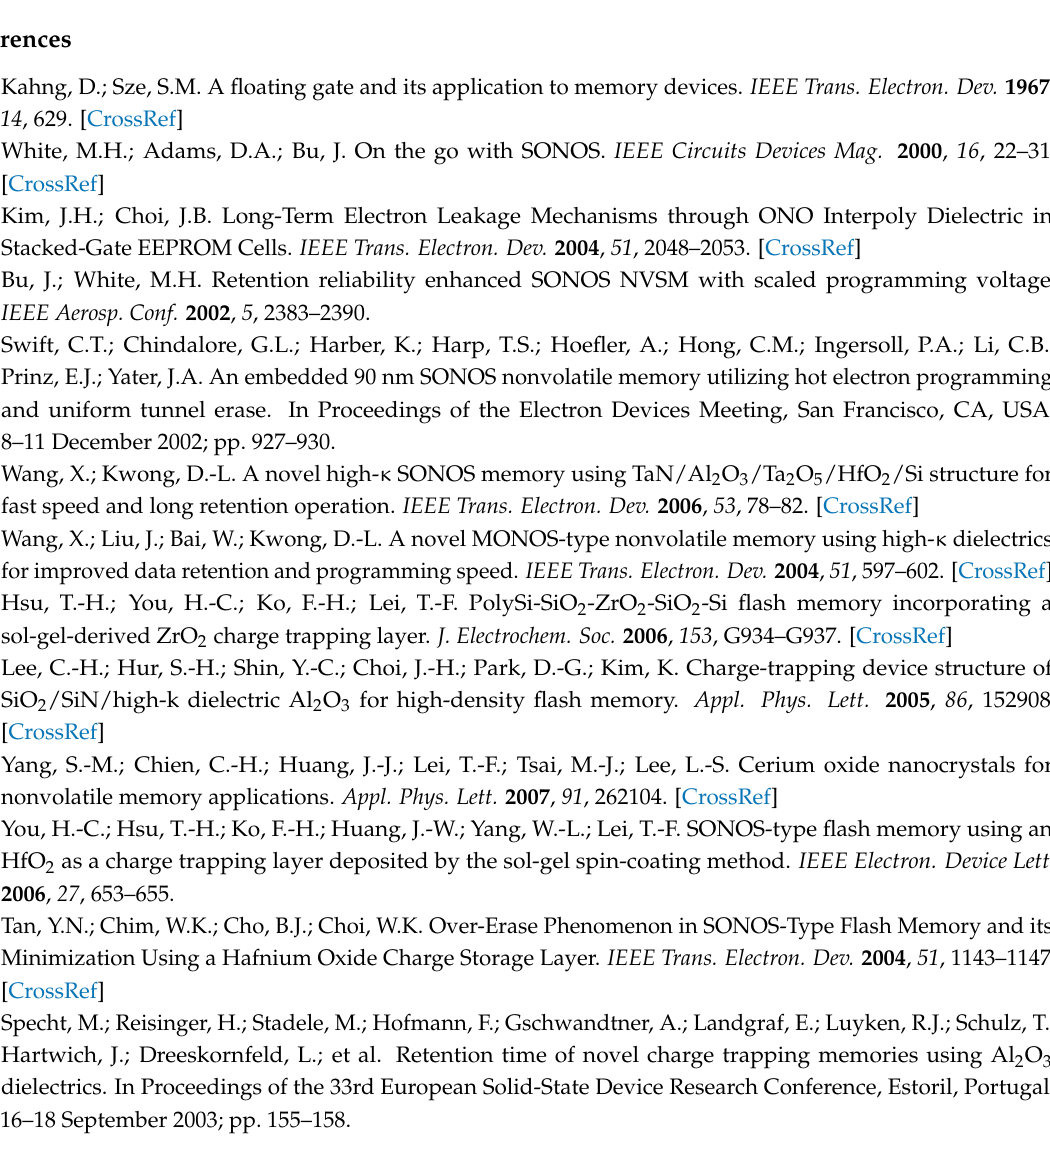
Figure S1: (a) Nb 2 O 5 and (b) TiNb 2 O 7 charge trapping nano-layers for different temperature after applying various bias; Figure S2: Programming speed of Nb 2 O 5 trapping layer for (a) 800 ◦ C, and (b) 900 ◦ C after applying various bias, and programming speed of TiNb 2 O 7 trapping layer for (c) 800 ◦ C, and (d) 900 ◦ C after applying various bias; Figure S3: Erasing speed of Nb 2 O 5 trapping layer for (a) 800 ◦ C, and (b) 900 ◦ C after applying various bias, and erasing speed of TiNb 2 O 7 trapping layer for (c) 800 ◦ C, and (d) 900 ◦ C after applying various